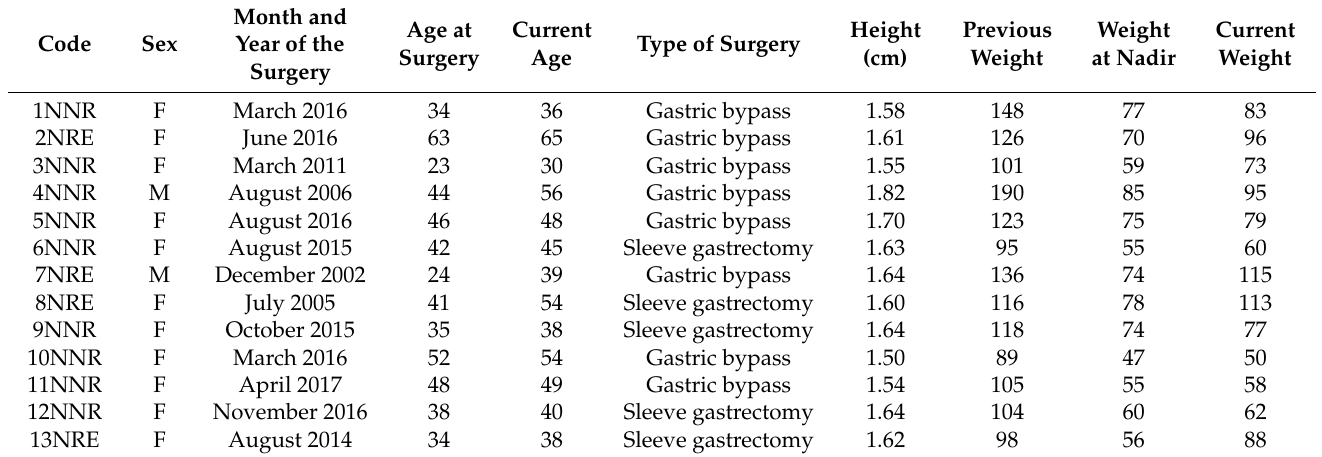
Table 7. Characterization of participants in the semi-structured